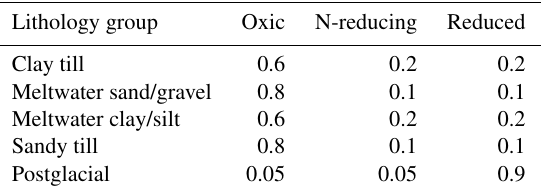
Table 3. The probabilities for redox conditions (oxic, N-reducing and reduced) based on geochemical observations in Fig. 5 for the top (surface) layer of the training images. The probabilities for each lithology group sum to